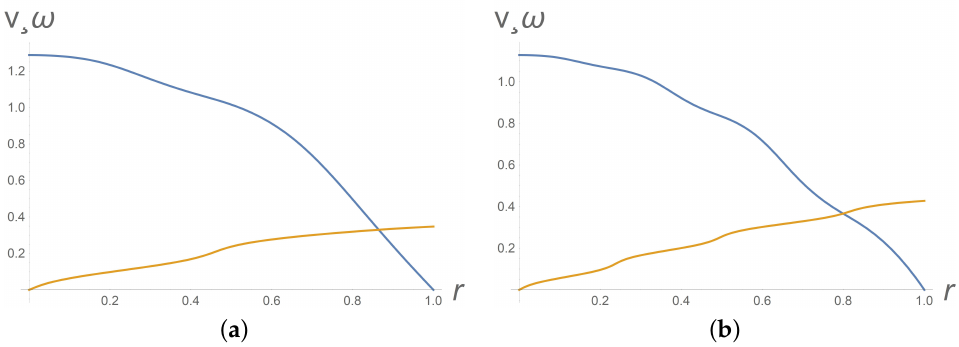
Figure 3. Gradient banding instability with respect to time. From top to bottom, dimensionless velocity v ( y ) and dimensionless micro-spin ω ( y ) profiles at Π = 2.85 for different dimensionless times t = 15 ( a ) and t = 25 ( b ). Values of other parameters are as in the data list (29).